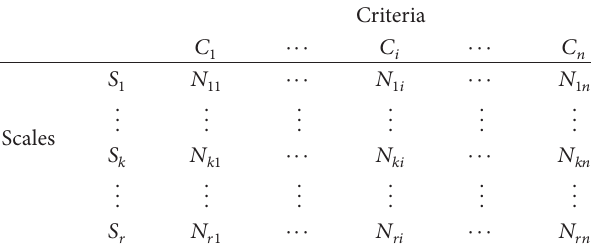
Table 2: Matrix of frequency that scale gives to